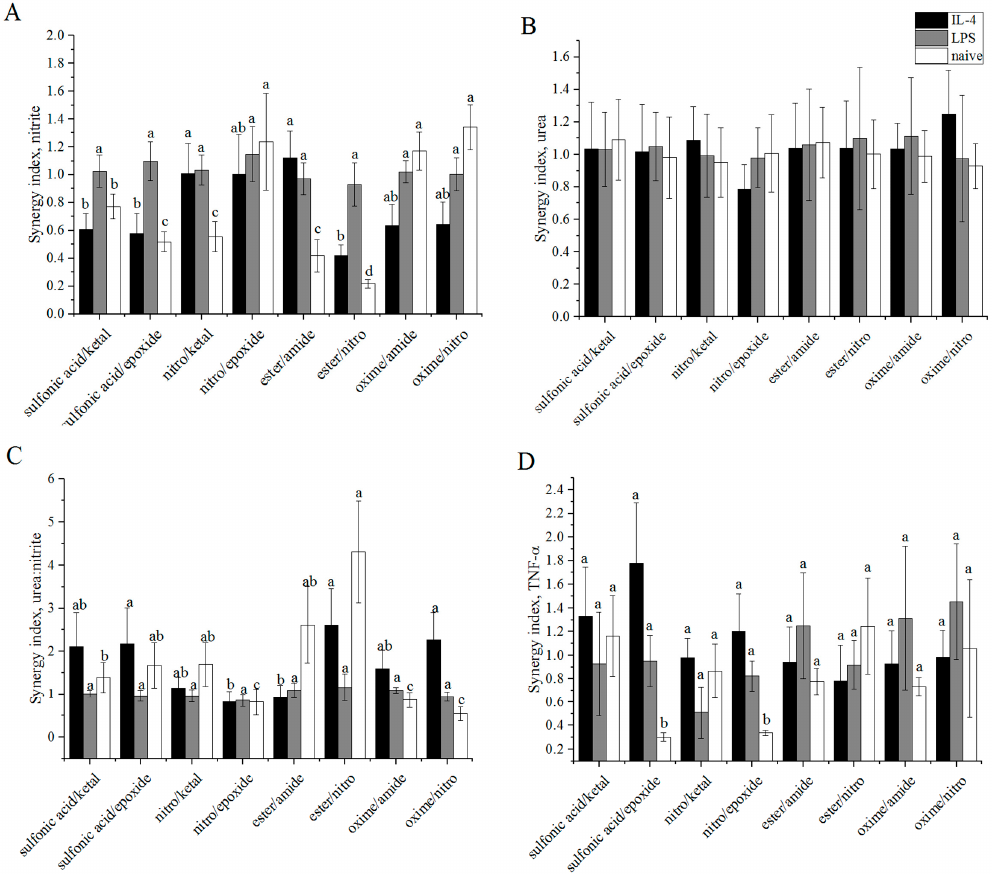
Figure 6. Synergistic indices for molecules produced by polarized RAW 264.7 macrophages: ( A ) nitrite; ( B ) urea; ( C ) urea:nitrite; and ( D ) TNF- α for M(LPS), M(IL-4), and M(0) cells were calculated based on previously obtained values for single modifications of alginates [9]. n = 4. Data represent the mean value ± standard deviation. Bars with the same letter (a–d) are not statistically different ( p < 0.05) from data points of the same activation. All measured values in panel B were statistically similar.